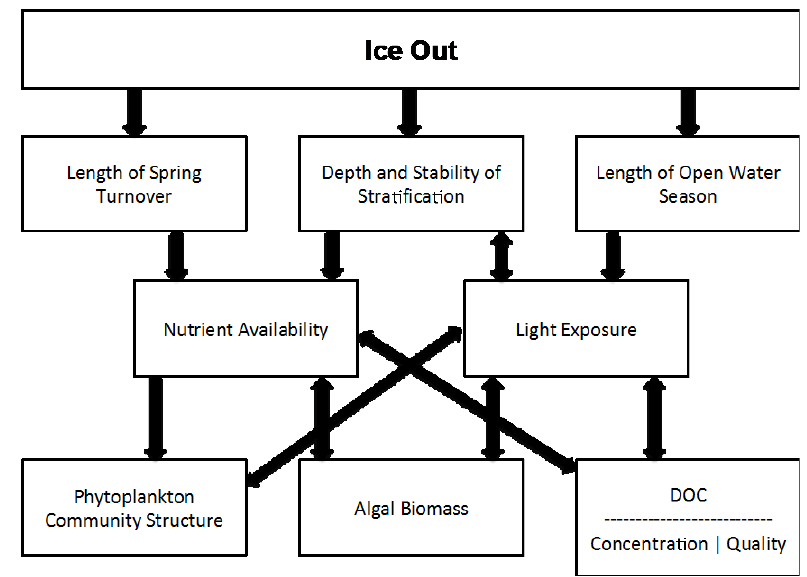
Figure 1. Conceptual diagram of a subset of the potential effects of ice-out on lake ecosystems.